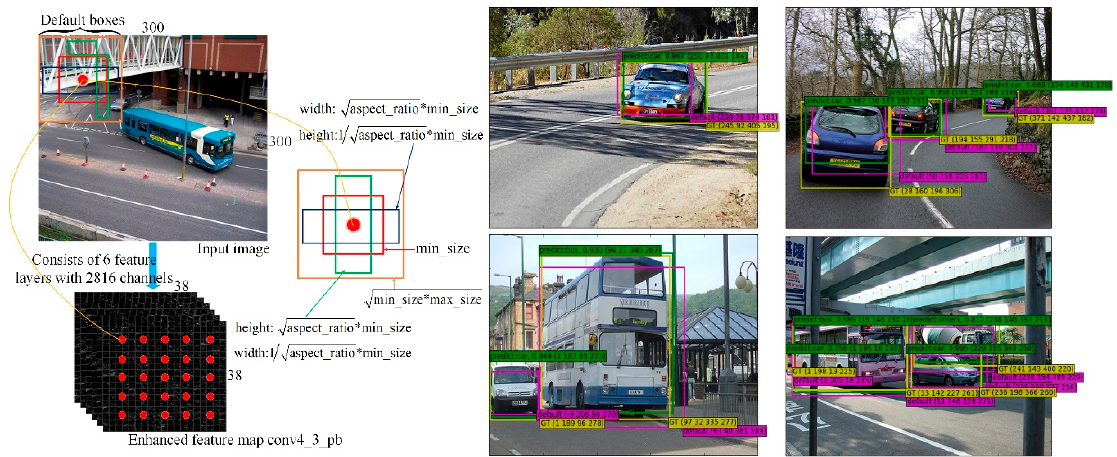
Figure 3. Left : Feature map concatenation and the calculation of default boxes with multiple aspect ratios and scales in the process; Right : Example detections using DP-SSD300 with new default box size in Table 2 on PASCAL VOC 2007 car dataset. Table 2. The learned average default box size for each feature map cell in different concatenated feature layers using the extend VGGNet (300 × 300 input).